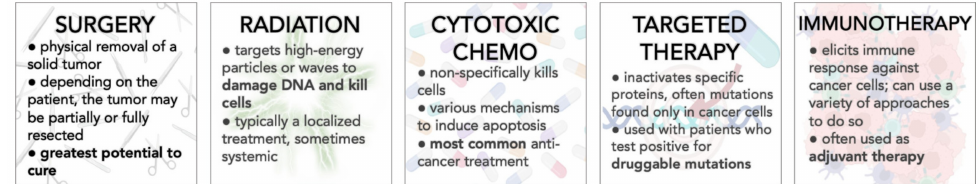
Figure 1. Overview of current common approaches to cancer treatment. Treatment strategies are chosen for a patient depending on the location and stage of the tumor. Additionally, tumors are often tested for targetable mutations to determine whether the patient is eligible for targeted therapy or not. Immunotherapy is often used as adjuvant